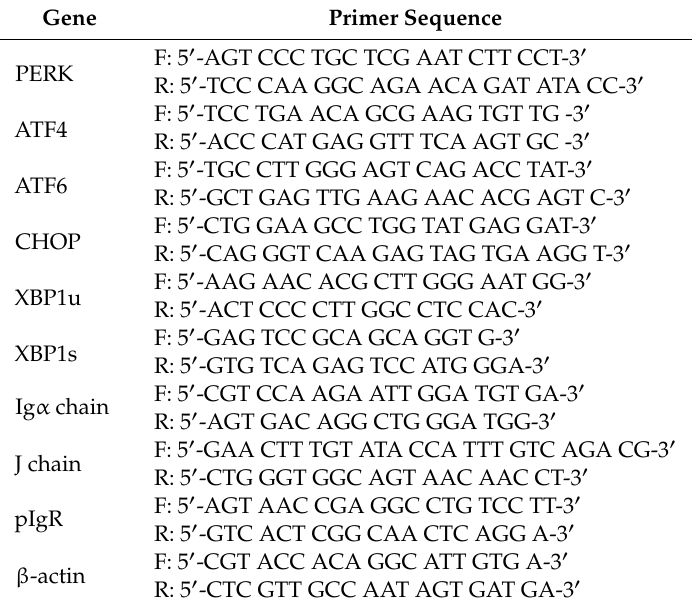
Table 1. Sequences of the qRT-PCR primers. Primers used to measure the expression levels of genes associated with endoplasmic reticulum (ER)-stress and IgA immune responses. β -actin was used as an endogenous